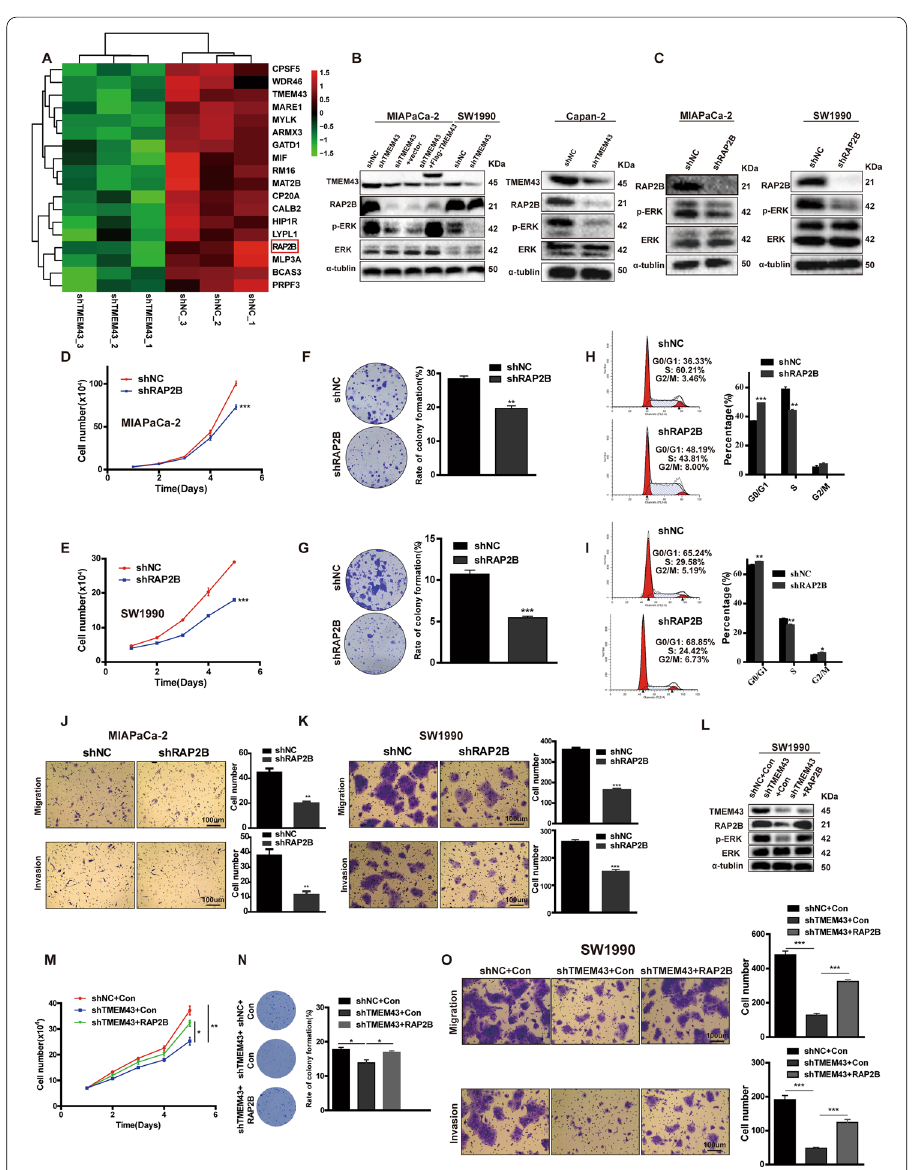
Fig. 3 The RAP2B/ERK pathway is essential for TMEM43-mediated pancreatic cancer progression. A Heatmap showing proteins with partly differential expression in TMEM43-silenced MIAPaCa-2 cells and control cells. B RAP2B, ERK, and p-ERK protein expression levels were detected in TMEM43-silenced, TMEM43-overexpressing cells, and the corresponding control cells. C The indicated protein expression levels were measured in RAP2B-silenced cells and control cells. D , E Cell proliferation abilities were determined in RAP2B-silenced MIAPaCa-2 cells ( D ), SW1990 cells E , and the corresponding control cells using the cell counting assay. F , G Colony formation assays showed the effect of RAP2B expression levels on the growth abilities of MIAPaCa-2 cells F and SW1990 cells ( G ). H , I The cell cycle in RAP2B-silenced MIAPaCa-2 ( H ), SW1990 I cells, and the corresponding control cells were detected using flow cytometry assays. J , K The migration and invasion abilities were detected in RAP2B-knockdown MIAPaCa-2 ( J ), SW1990 cells K , and control cells. L Western blot showing the protein expression level in SW1990 cells stably transfected with control, shTMEM43, or shTMEM43 plus RAP2B. M – O Cell counting, colony formation, and transwell assays showing that the suppression of proliferation, migration, and invasion by shTMEM43 in SW1990 cells was partially abolished by RAP2B. Scale bar 100 μm. Results are shown as the mean SD of three independent replicates. * p < 0.05, = ± ** p < 0.01, *** p <